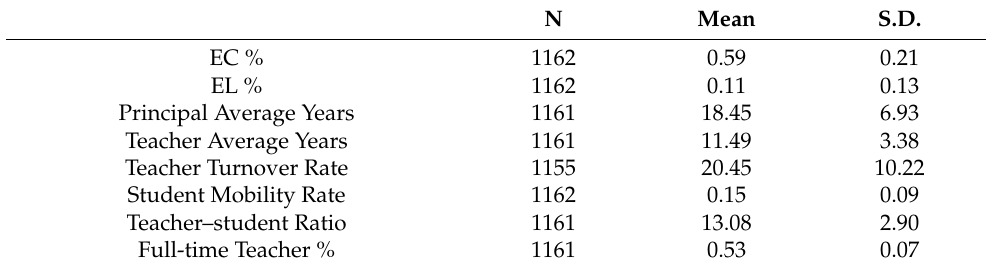
Table 2. Descriptive statistics of school district-level characteristics in academic year 2016–2017.